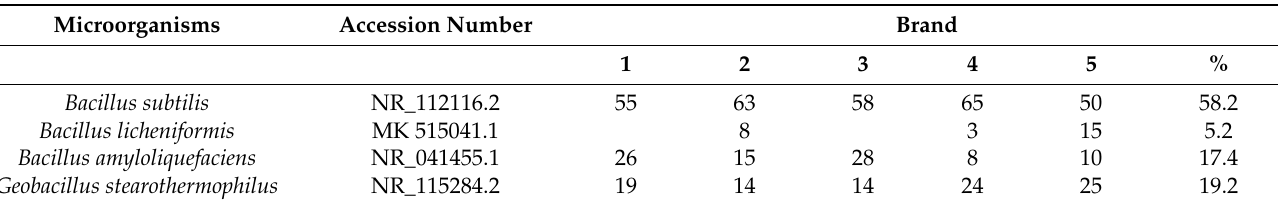
Table 8. Bacterial species isolated from cocoa